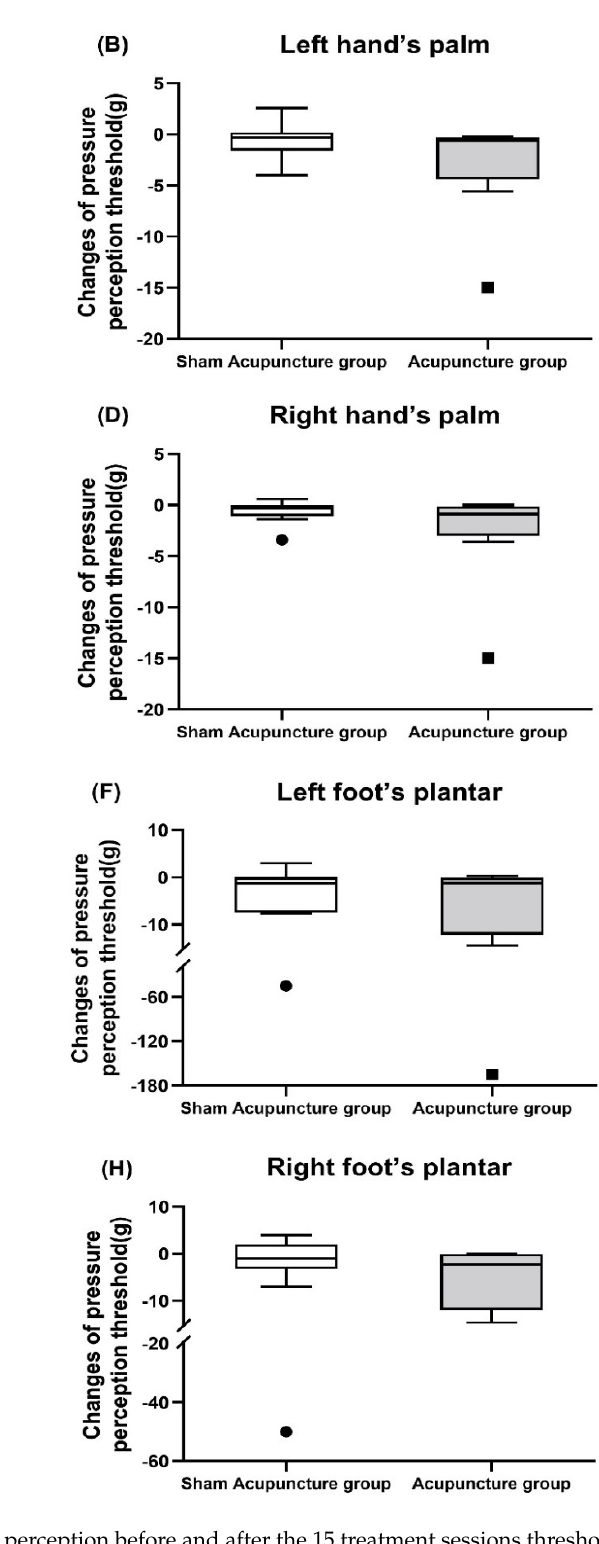
Figure 4. ( A – H ) Changes in the mechanical touch-pressure perception before and after the 15 treatment sessions threshold. Data are presented as minimum and maximum values and lower, middle, and upper quartiles for each group. # p < 0.05 represents the between-group values validated by the Mann–Whitney U test.